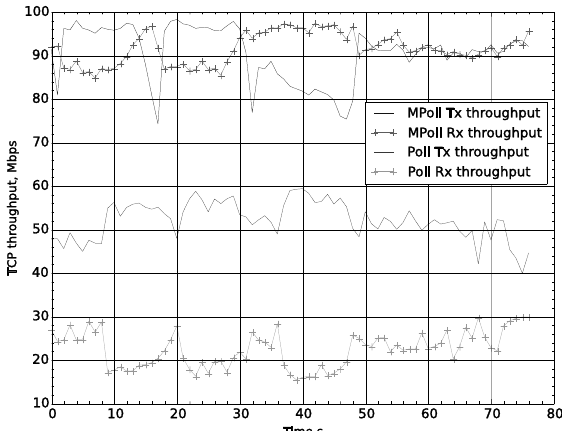
Fig. 8. Maximum throughput through one active station when the total of 83 stations are connected to